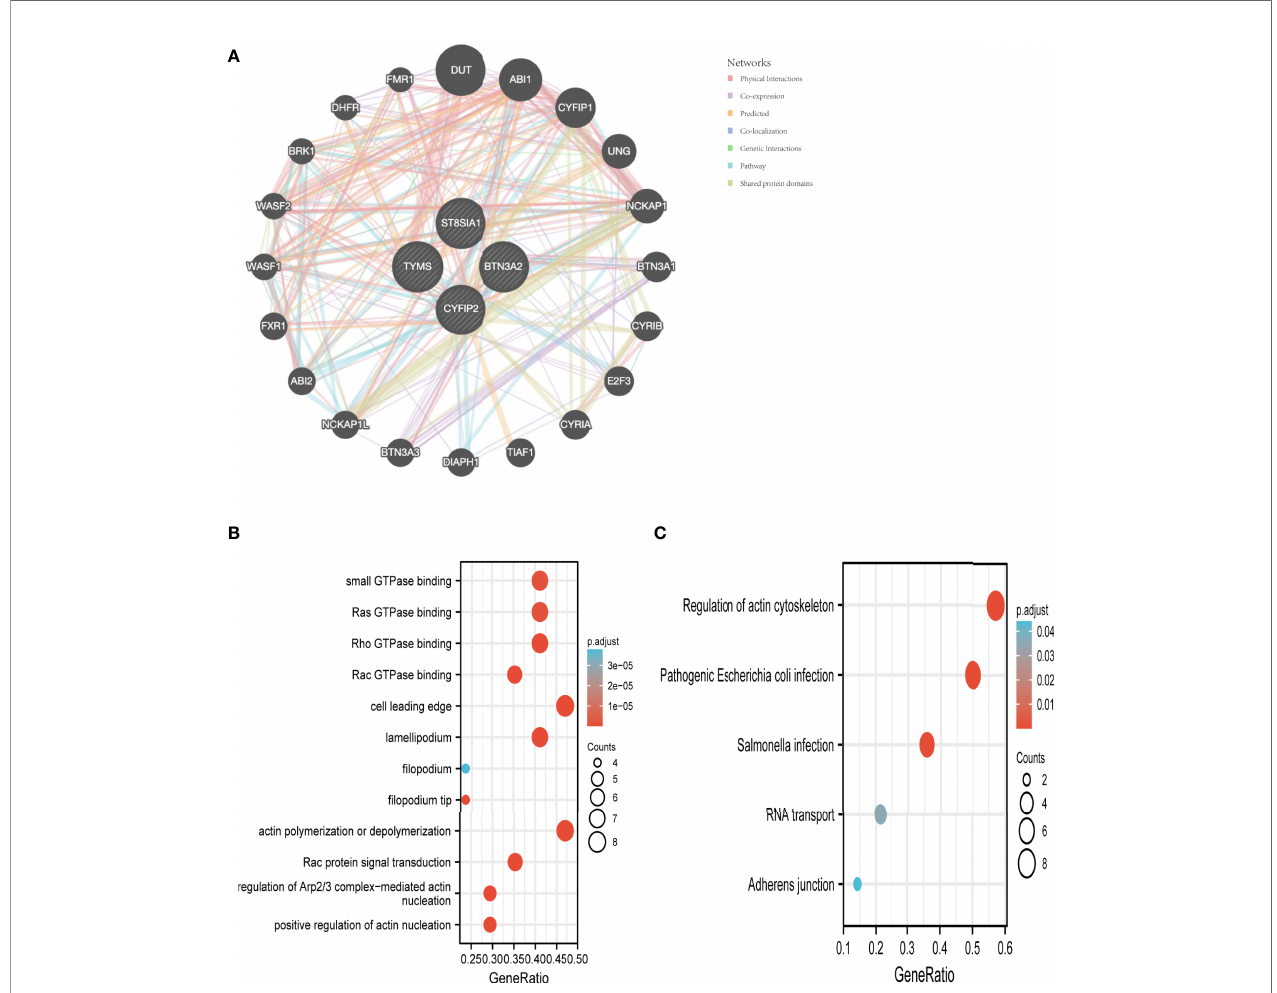
FIGURE 6 | Interaction analysis of feature genes. (A) Characterized gene co – expression network. (B) GO analysis of co – expressed genes. (C) Co – expressed gene KEGG